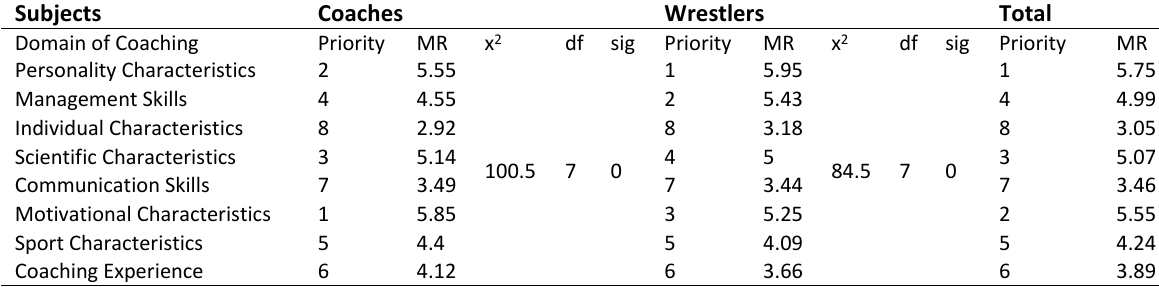
Table 2. Priority of coaching dimensions by Coaches, and Wrestlers Subjects